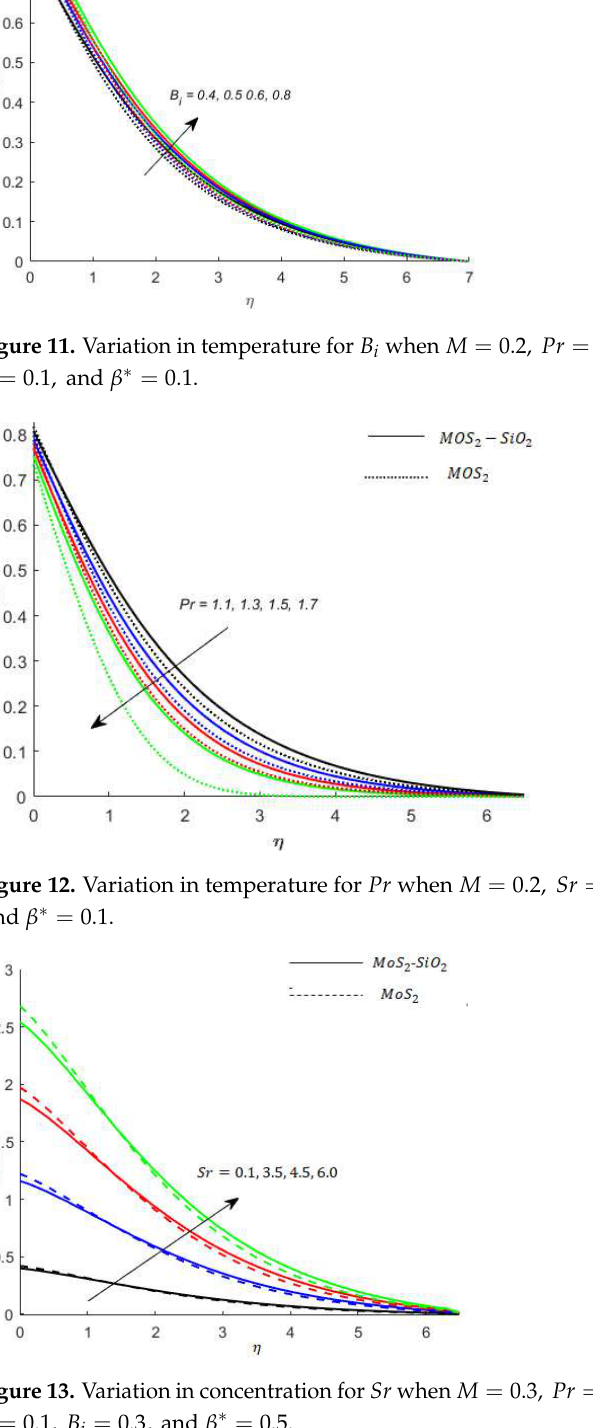
Figure 13. Variation in concentration for Sr when M = 0.3, Pr = 2.5, Ec = 0.3, Sc = 0.3, ( Gr ) (cid:3030) = 0.1,𝐾 = 0.1,𝐵 (cid:3036) = 0.3,and 𝛽 ∗ = 0.5.